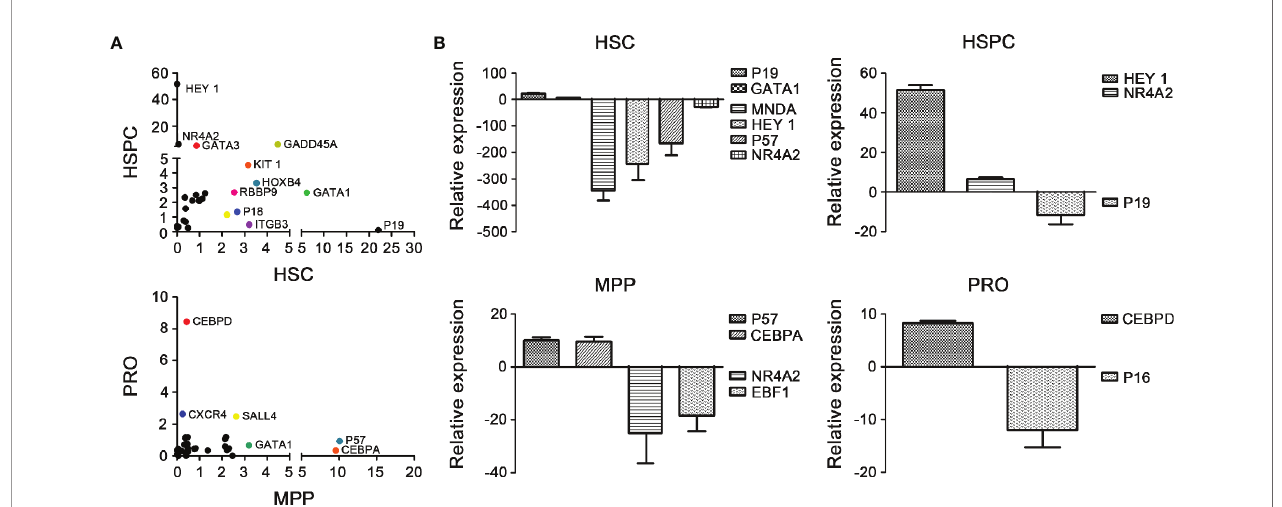
FIGURE 4 | Differential expression analysis of the genes related to hematopoiesis in cultured hematopoietic cells with or without chrysin treatment. (A) Scatter plot of mRNA pro fi le showing upregulated genes in cultured HSCs (26 genes), HSPCs (26 genes), MPPs (28 genes), and PROs (26 genes) with C2968 treatment. The genes exhibiting signi fi cant changes in expression compared with the control group are labeled (p < 0.001). (B) Fold changes of relative mRNA expression of the most signi fi cant upregulated or downregulated genes in cultured HSCs, HSPCs, MPPs, or PROs with C2968 treatment. All data were normalized to the expression levels in control (DMSO 0.01%) group. Graphs show means ± SD (n = 100 cells). HSCs, hematopoietic stem cells; HSPCs, hematopoietic stem and progenitor cells; MPPs, multipotential progenitor cells; PROs, progenitor